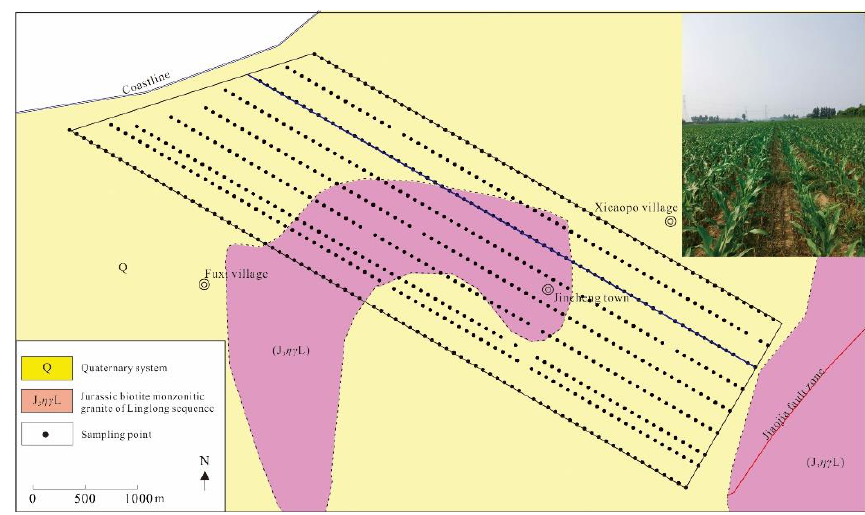
Figure 4. Geological sketch map and sampling sites of Qujia Au deposit.